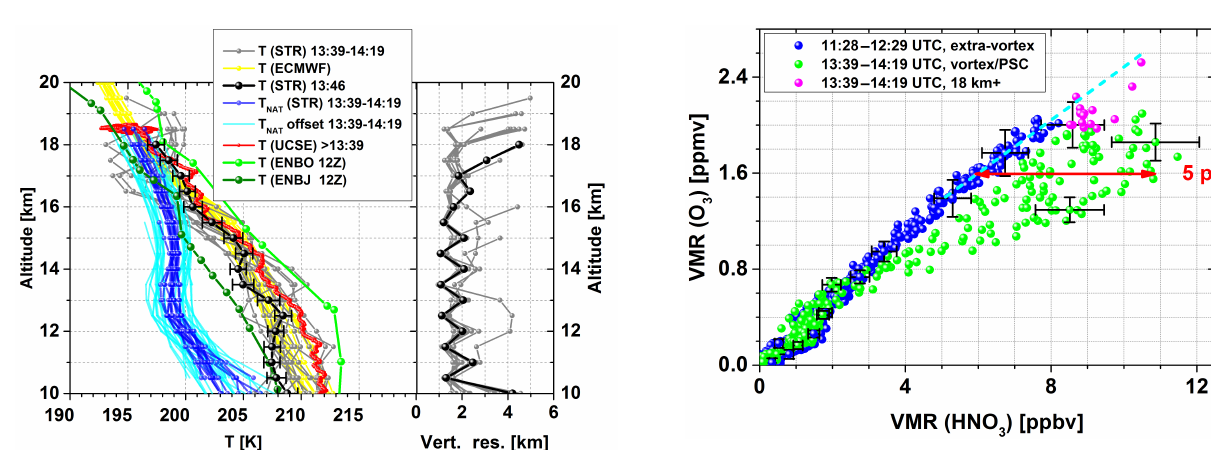
Figure 7. Left panel: MIPAS-STR temperature profiles (grey) as- sociated with the Geophysica PSC encounter. Associated ECMWF initial guess/a priori profiles (yellow). Individual MIPAS-STR tem- perature profile (black) with combined random and systematic 1 σ - uncertainties. In situ measurements by the Geophysica UCSE on- board temperature sensor (red) during the PSC encounter and the subsequent descent phase. Radiosonde temperature profiles from Bodø (ENBO, green) and Bjornoya (ENBJ, dark green). T NAT pro- files calculated from the MIPAS-STR HNO 3 ( g ) and H 2 O ( g ) pro- files during the PSC encounter (blue) together with the same pro- files (cyan) considering a simultaneous + 20% and a simultaneous − 20% offset for both species, respectively. Right panel: vertical resolutions of MIPAS-STR profiles.